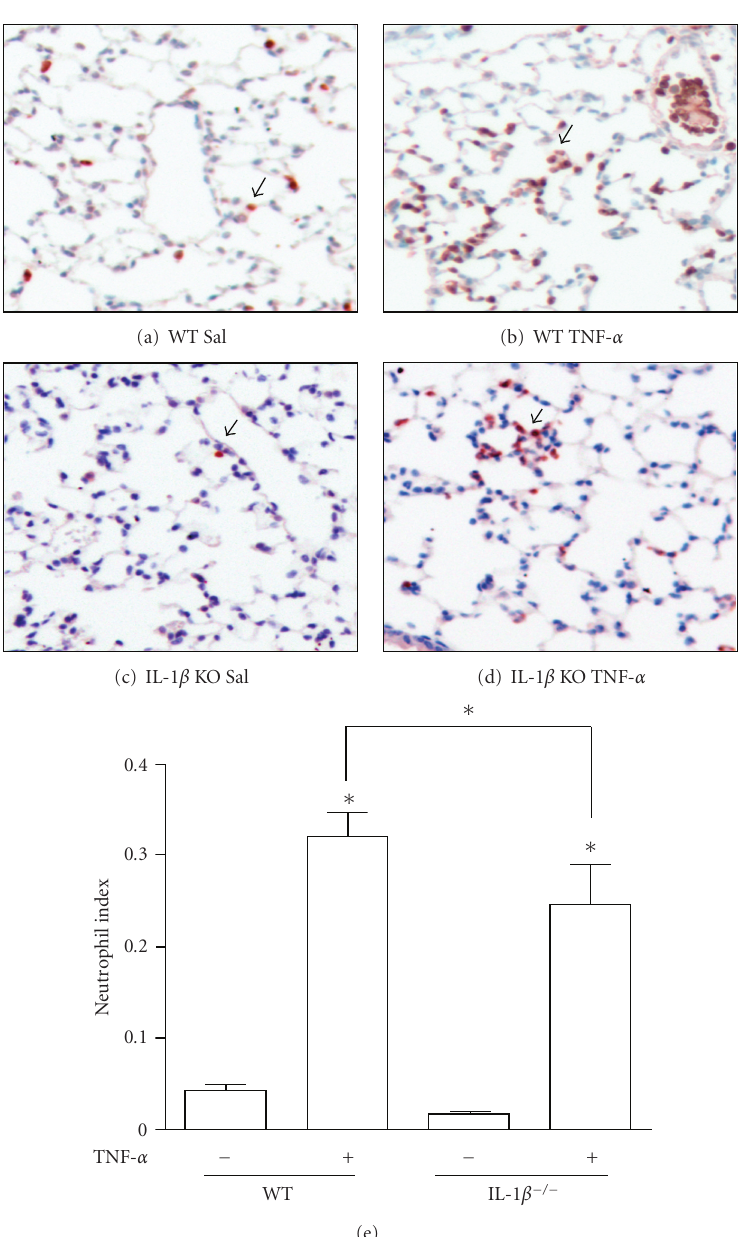
Figure 1: Neutrophil accumulation in mouse lungs exposed to TNF- α . Wildtype (WT) or IL-1 β knockout ( / KO) mice were instilled into the oropharynx (OP) with saline (50 μ L) or rmTNF- α (5 μ g in 50 μ L saline/mouse). After 6 hours, lungs were formalin fixed and neutrophil antigen-positive cells were identified by immunohistochemistry (arrows). Images were captured through 10x objective. In the graphical analysis, a neutrophil index was determined as the ratio of neutrophil-positive cells per total number of nuclei per low power field. Three to twelve random fields were analyzed per lung section. Data are represented as mean ± SEM, n = 9–11 lung sections per TNF group. ∗ represents P ≤ . 05 versus saline controls or (brackets) between cytokine-treated